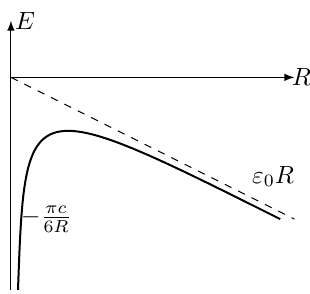
Figure 1. Finite-size ground state energy E 0 ( R ) of a conventional Wilsonian relativistic QFT. Its R → 0 behavior − πc/ 6 R is controlled by the UV fixed point. At large R , E 0 ( R ) shows the linear behavior ’ ε , with the slope ε representing the bulk vacuum energy density. We have to stress 0 R 0 that the TBA equations actually compute the difference E ( R ) − ε , and in our subsequent vac 0 R analysis E ( R ) stands for this difference. (That is why in all plots below the R → ∞ slope of the primary branch is always set to